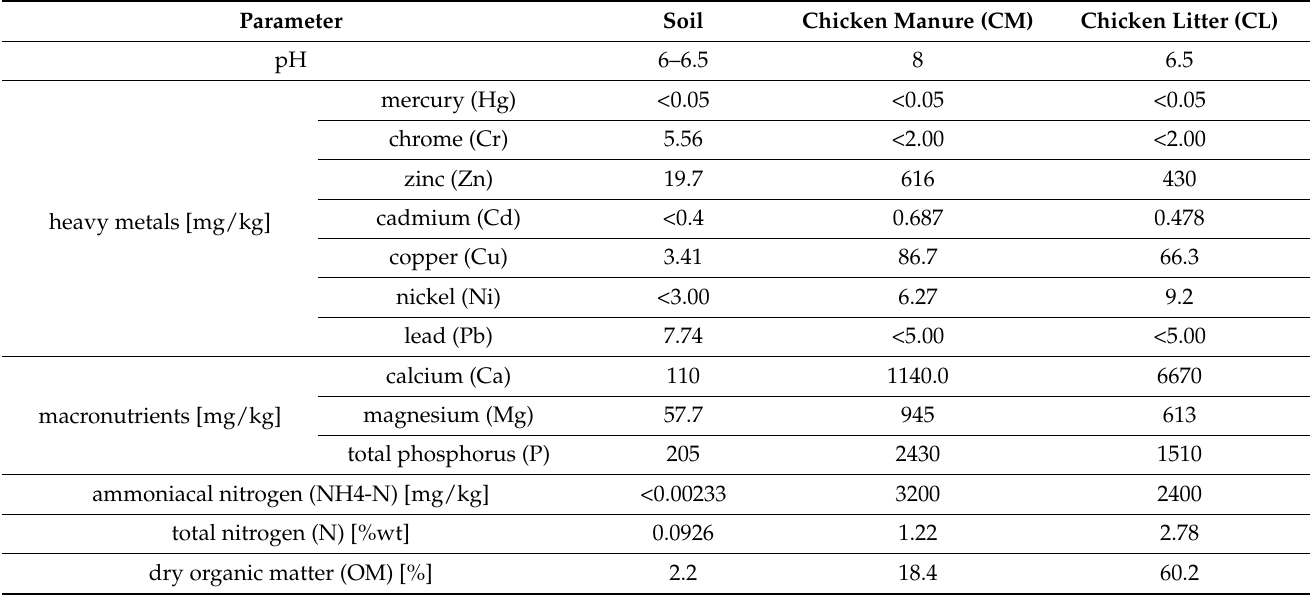
Table 2. Physicochemical properties of the two kinds of chicken manure from Polish commercial farm and non-manured